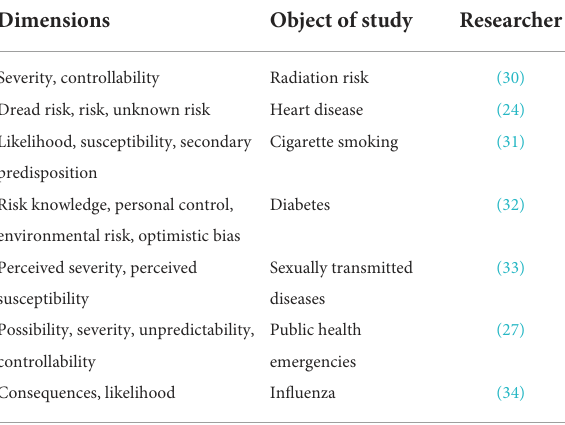
TABLE 1 Dimensions of health risk